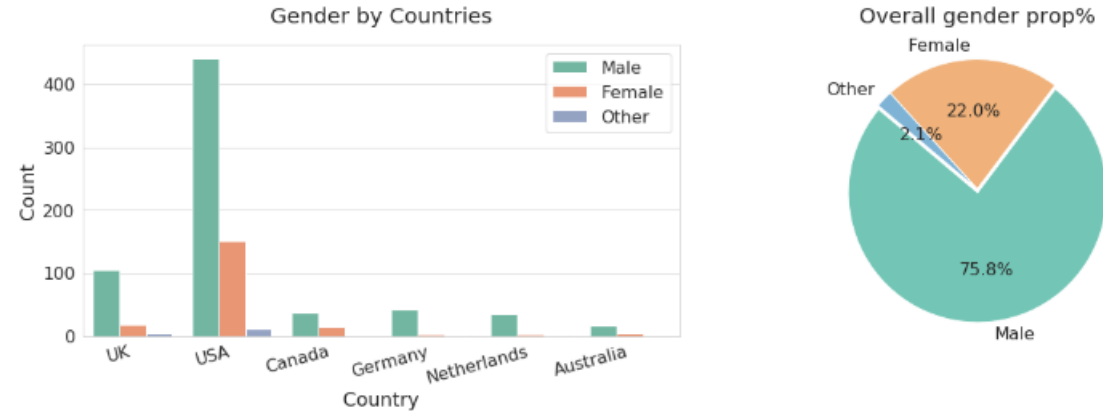
Figure 4: Gender by countries with overall proportional (only techs)